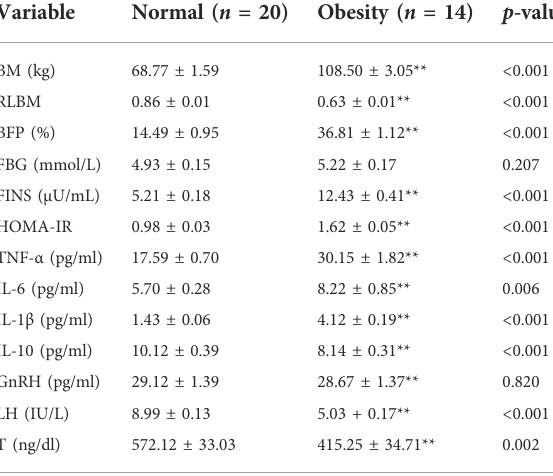
TABLE 1 Comparison of relate variables between normal group and obesity group.